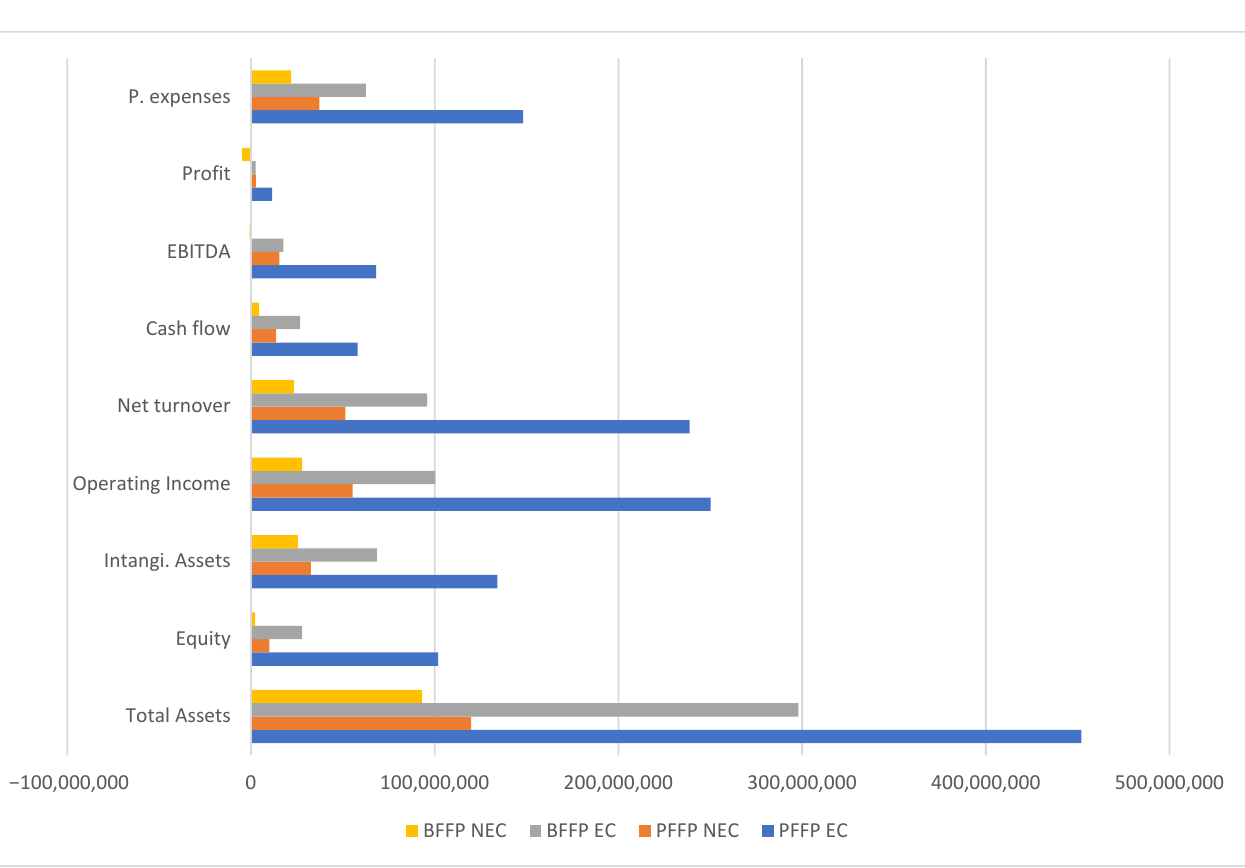
Figure 2. The evolution of the significant variables, comparing BFFP and PFFP.